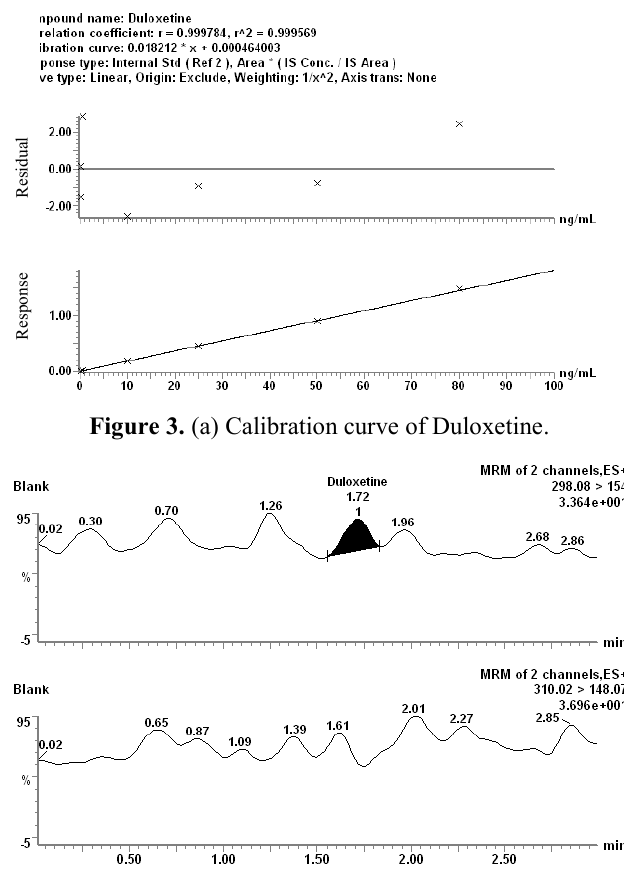
Figure 3. (b) Double blank plasma (without IS).